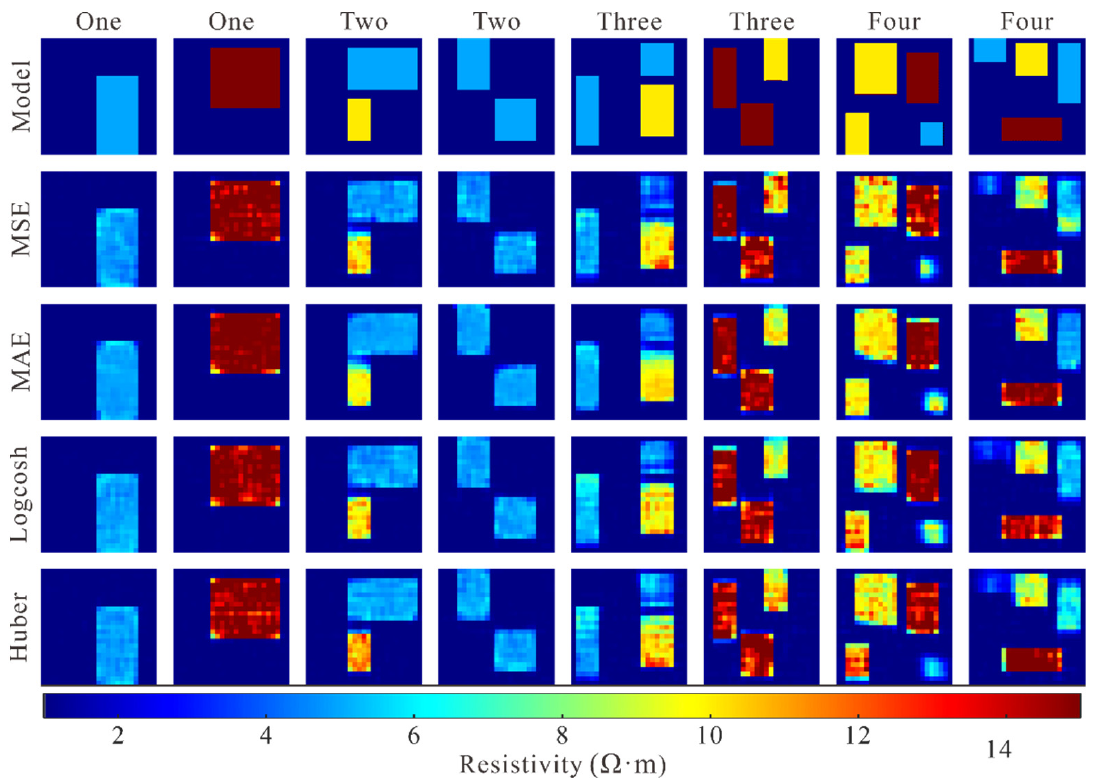
Figure 6. Model and their inversion results with using different loss functions.